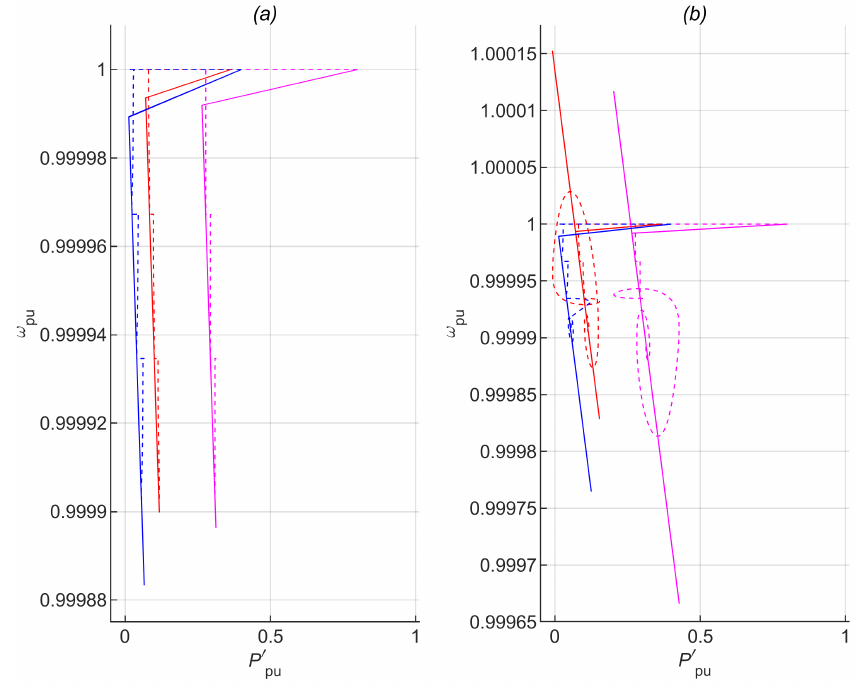
Figure 8. P (cid:48) − ω Droop Relation ( a ) no Jacobian, PFT corrected, ( b ) with Jacobian, PFT corrected; for VSIs at Buses (1—red, 2—magenta,